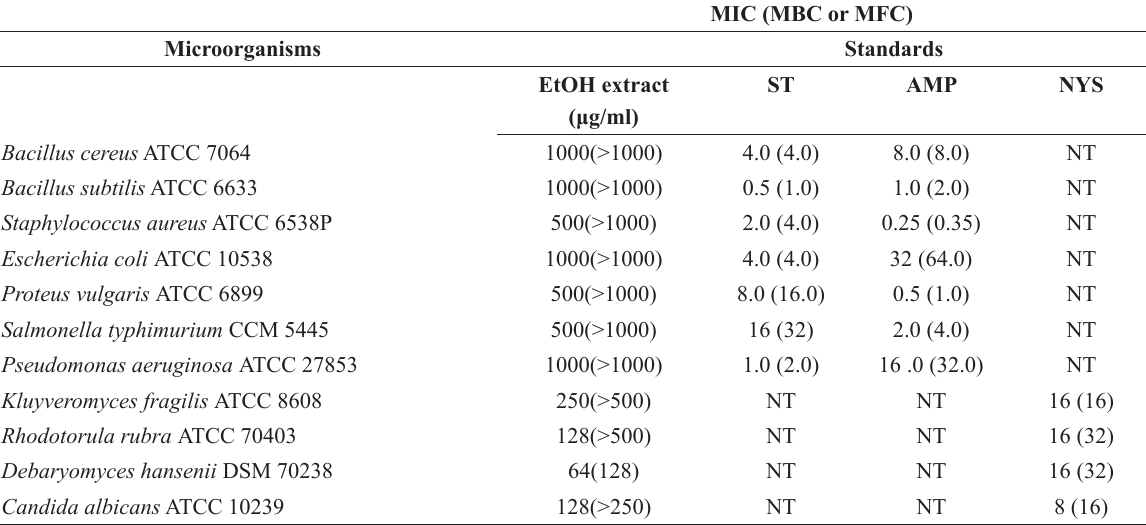
Minimum inhibitory concentration (MIC) of Phlomis russeliana .